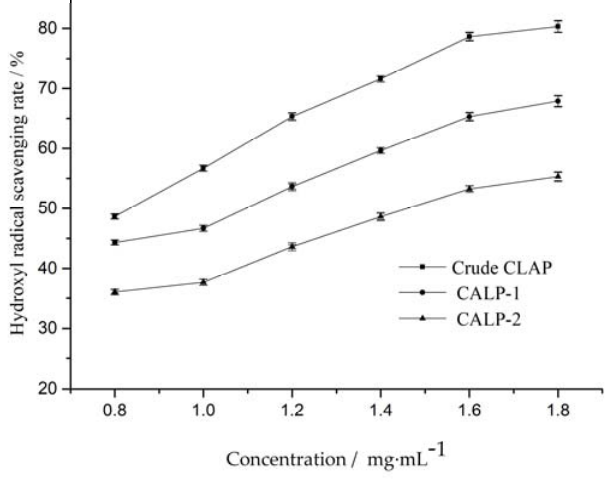
Figure 12. Scavenging activities of Choerospondias axillaris leaf polysaccharide on OH.